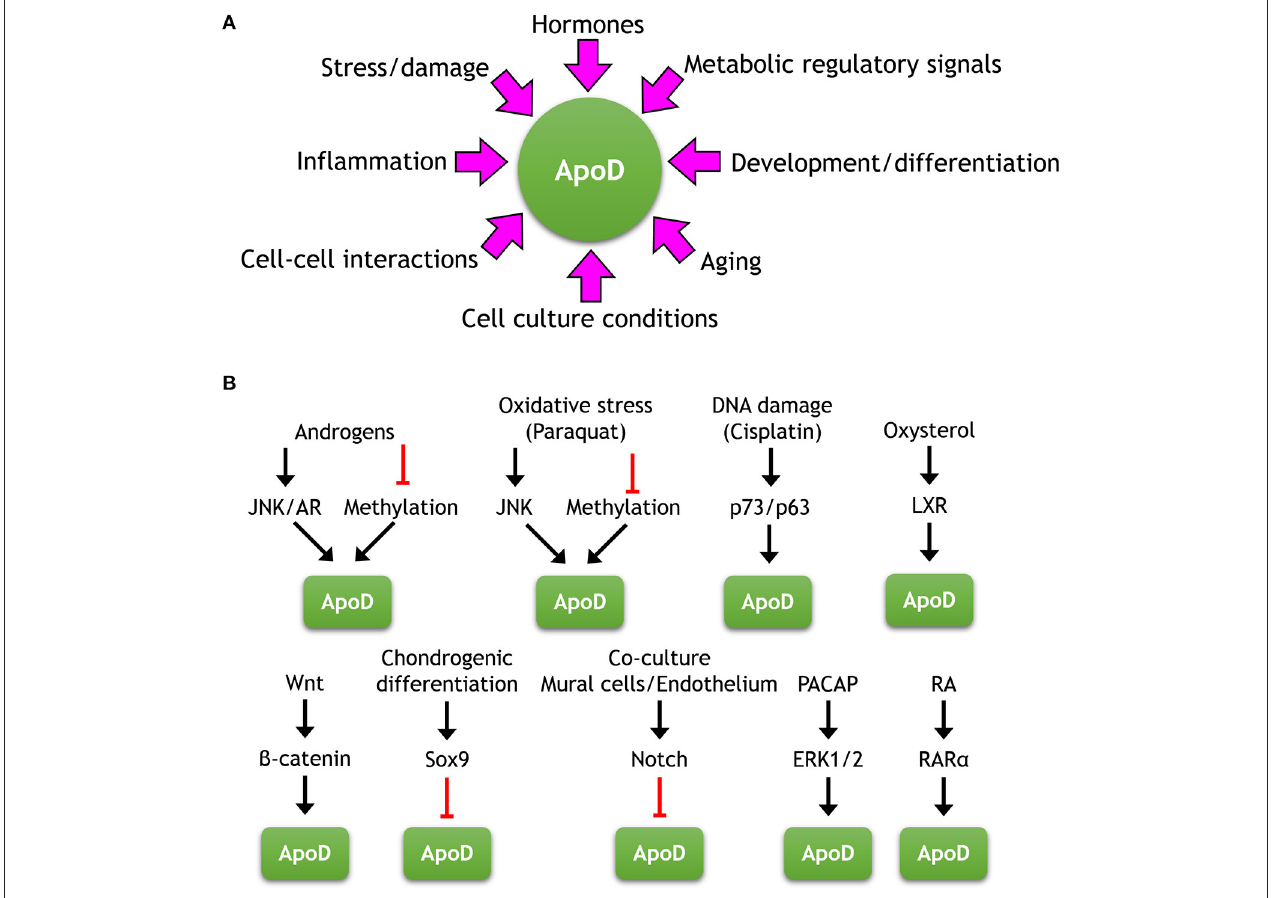
FIGURE 5 | Factors and pathways regulating the expression of ApoD. (A) Diverse stimuli regulate ApoD expression in a variety of cells and physiological conditions. (B) Summary of upstream regulatory pathways regulating ApoD expression where elements of the signaling cascade have been